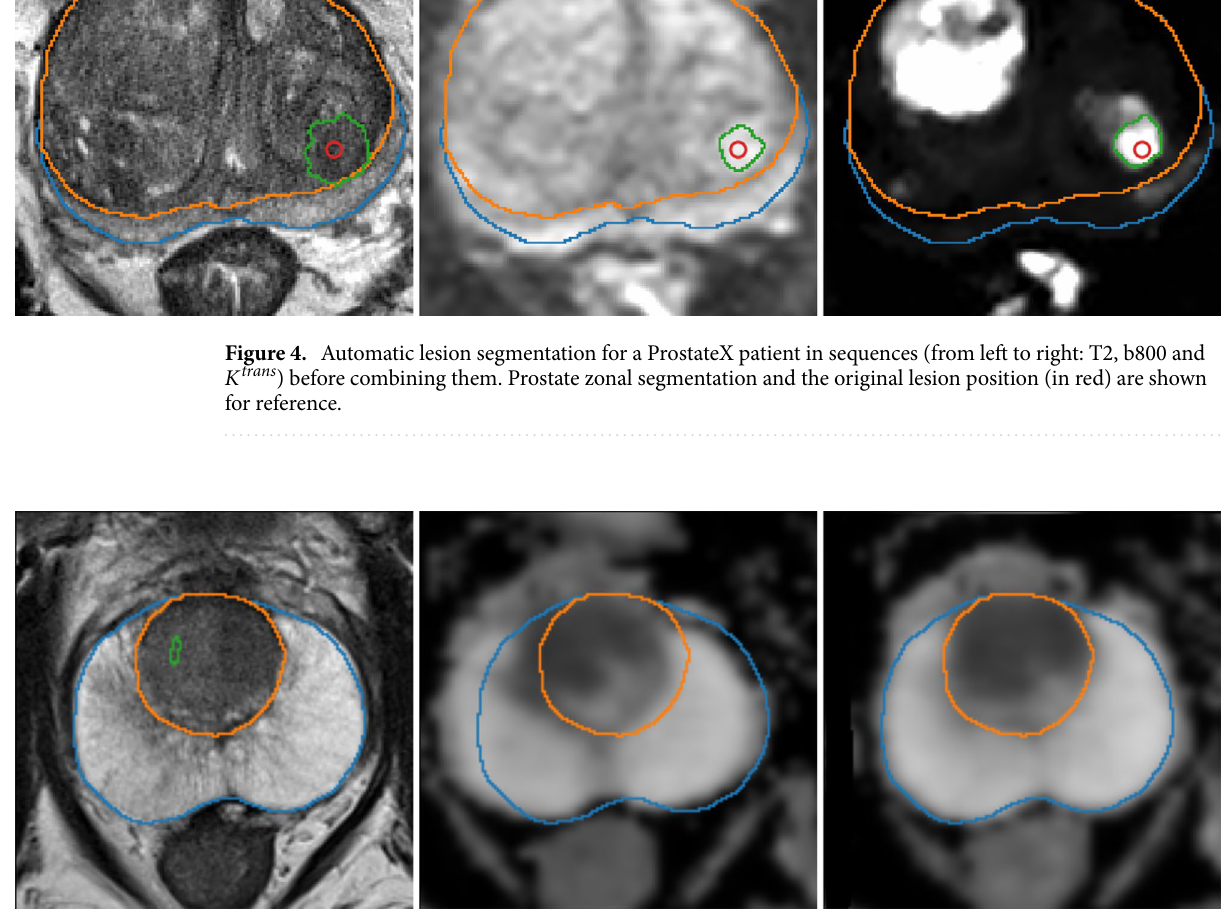
Figure 5. Automatic registration between T2 sequence (left) and ADC map (center: before, right: after) for a sample